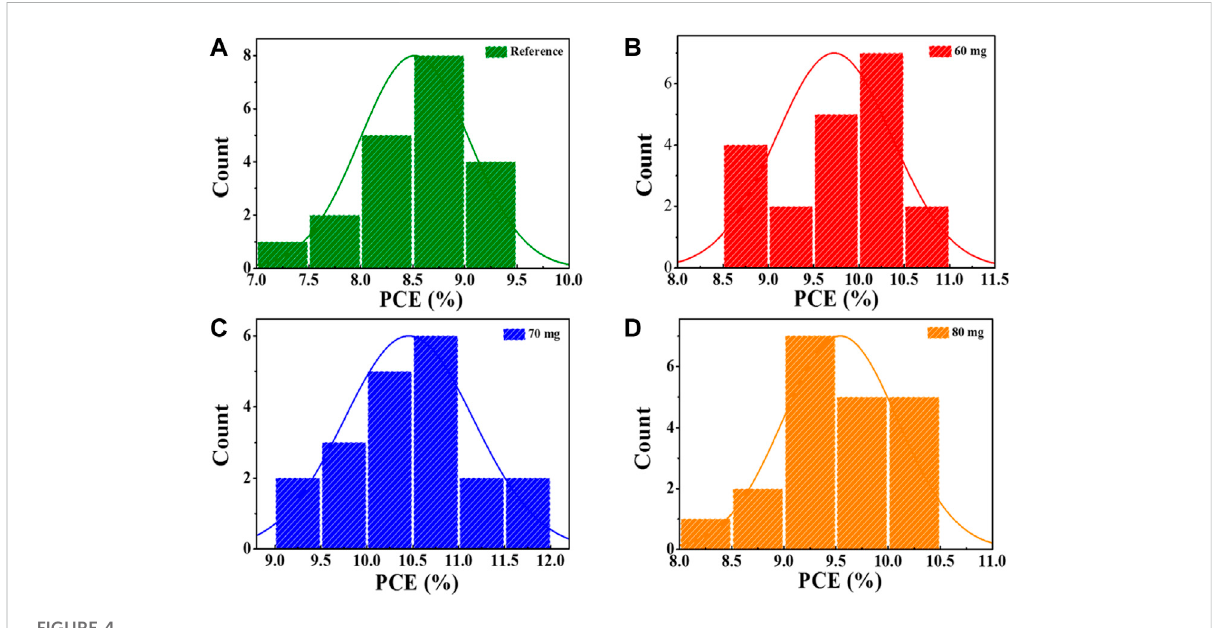
FIGURE 4 Statistical distribution of solar cell ef fi ciency with CZTSSe fi lms selenized under different Sb 2 Se 3 contents: (A) 0 mg, (B) 60 mg, (C) 70 mg, (D) 80